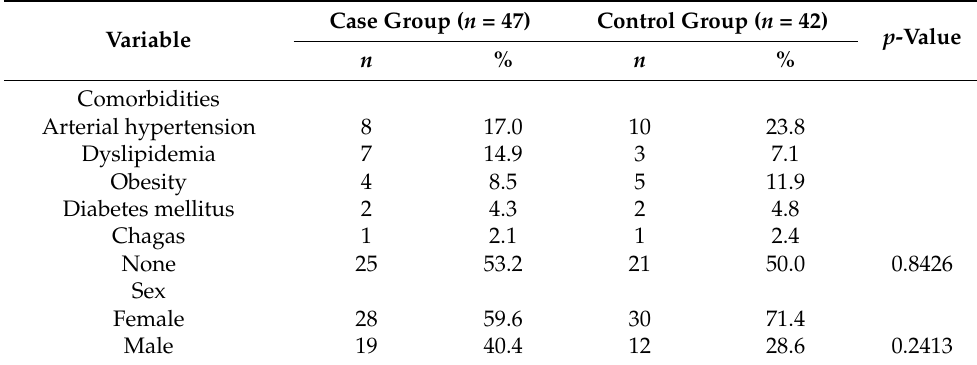
Table 2. Demographic characteristics of the case and control